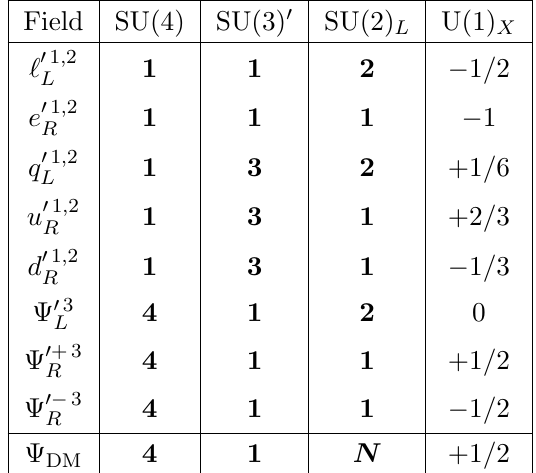
Table 1 . Quantum numbers of SM-like fermions (upper block) and the vector-like DM multiplet (cid:9) DM (last row). First and second generation fermions transform under SU(3) 0 (cid:2) SU(2) L (cid:2) U(1) X like the usual SM fermions; the third generation quarks and leptons are uni(cid:12)ed into (cid:9) 0 3 (cid:9) 0 +3